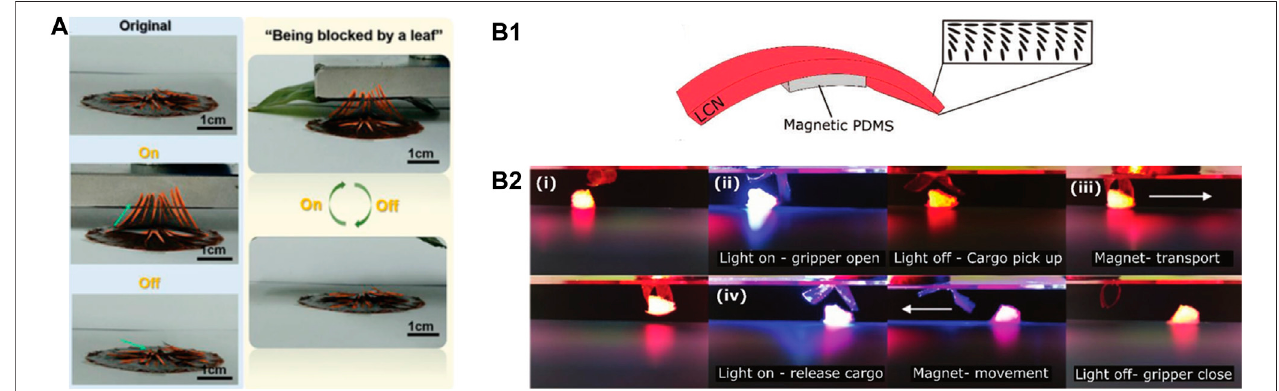
FIGURE9|(A) Photographsofa “ mimosapudica ” splayingandclosing,andmorphingblocked byaleafandexposedtomagnetic fi eld,respectively.Reproduced from Wang et al. (2019c) with permission of WILEY-VCH. (B1) Magneto-light responsive actuator with localized PDMS/Fe composite layer coated on LCN. (B2) The untethered pick up, transport, and release of a cargo, performed by the dual-responsive gripper within an enclosed space. Reproduced from Pilzda Cunha et al. (2019) with permission of